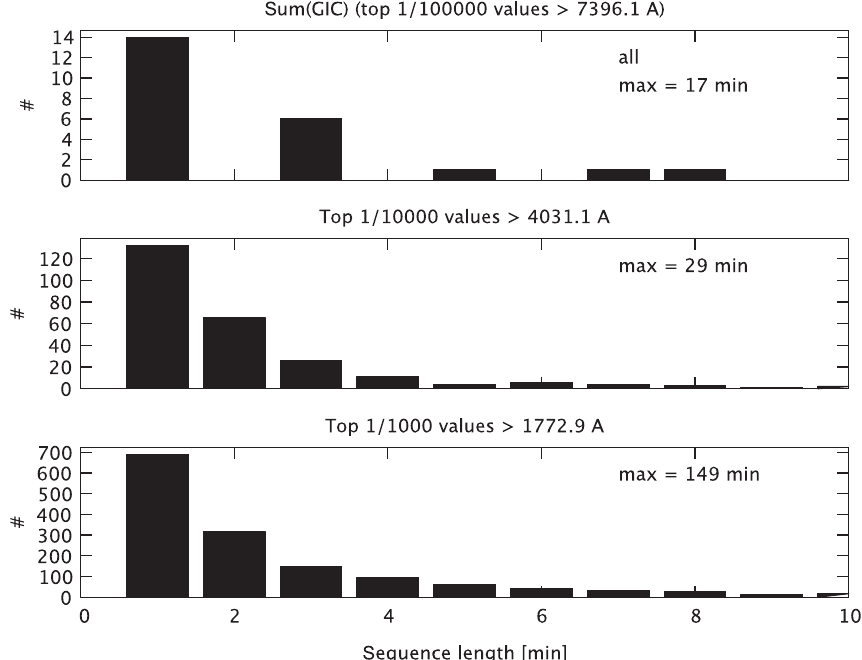
Fig. 9. Distribution of continuous sequences of the largest 1-min GIC sums in the European high-voltage power grid. From top to bottom: occurrence of the top 0.001%, 0.01%, 0.1% of all values. The maximum length of the sequences corresponding to each activity category is also given in the subplots.